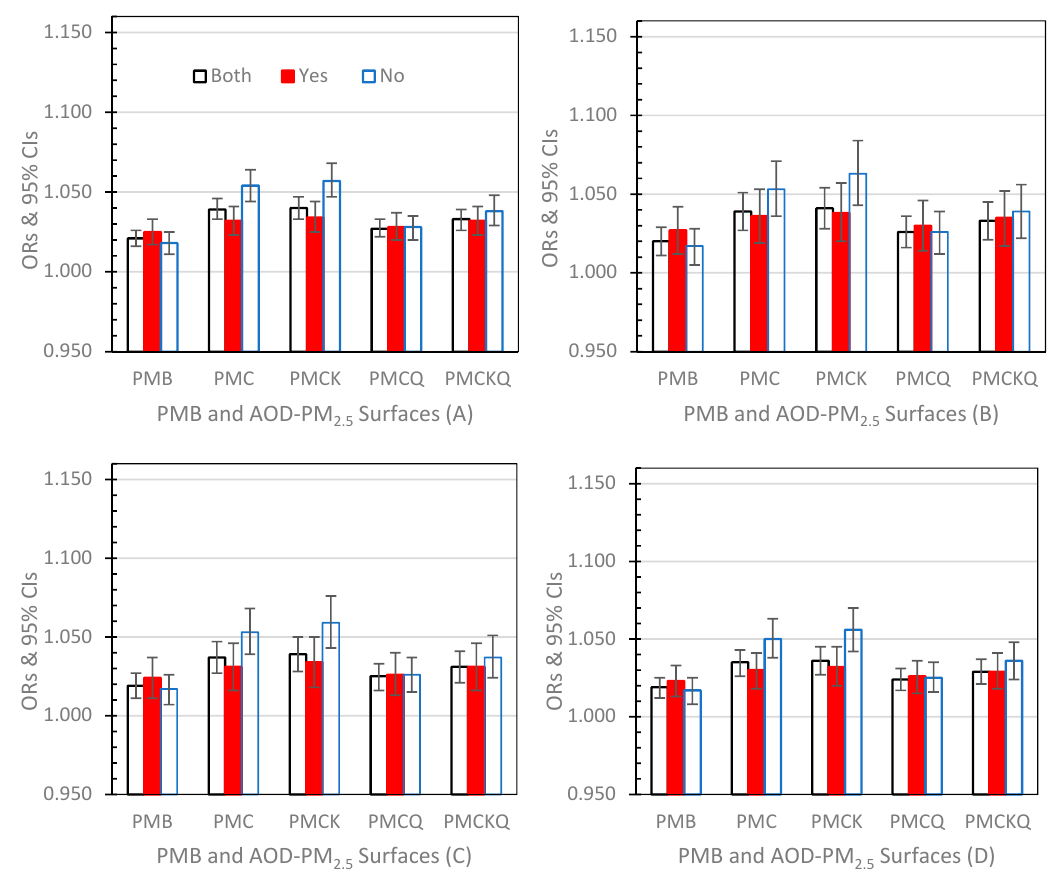
Figure 3. Odds Ratios (ORs) and 95% Confidence Intervals (CIs) for the four experimental AOD-PM 2.5 concentration surfaces and PMB under both grid conditions (Both), grids with monitors (Yes) and grids without monitors (No) at lag day 1: ( A ) ED asthma (top left panel), ( B ) IP asthma (top right panel), ( C ) IP MI (bottom left panel) and ( D ) IP HF (bottom right panel).